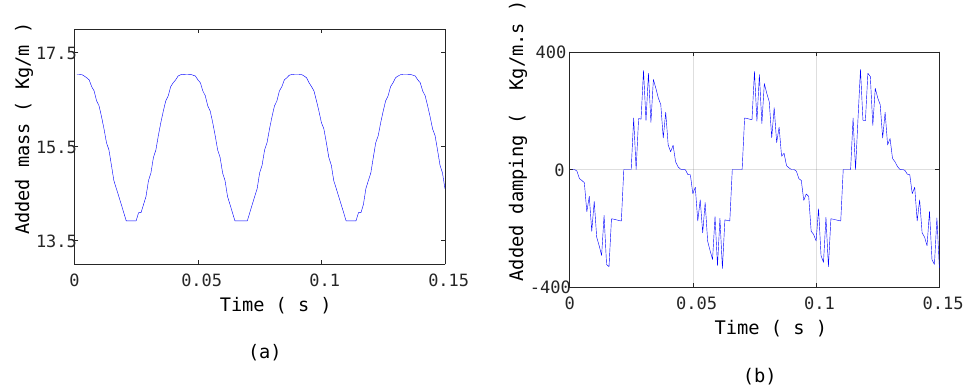
Figure 7. Solutions p (cid:48) L p ≈ Lp max .